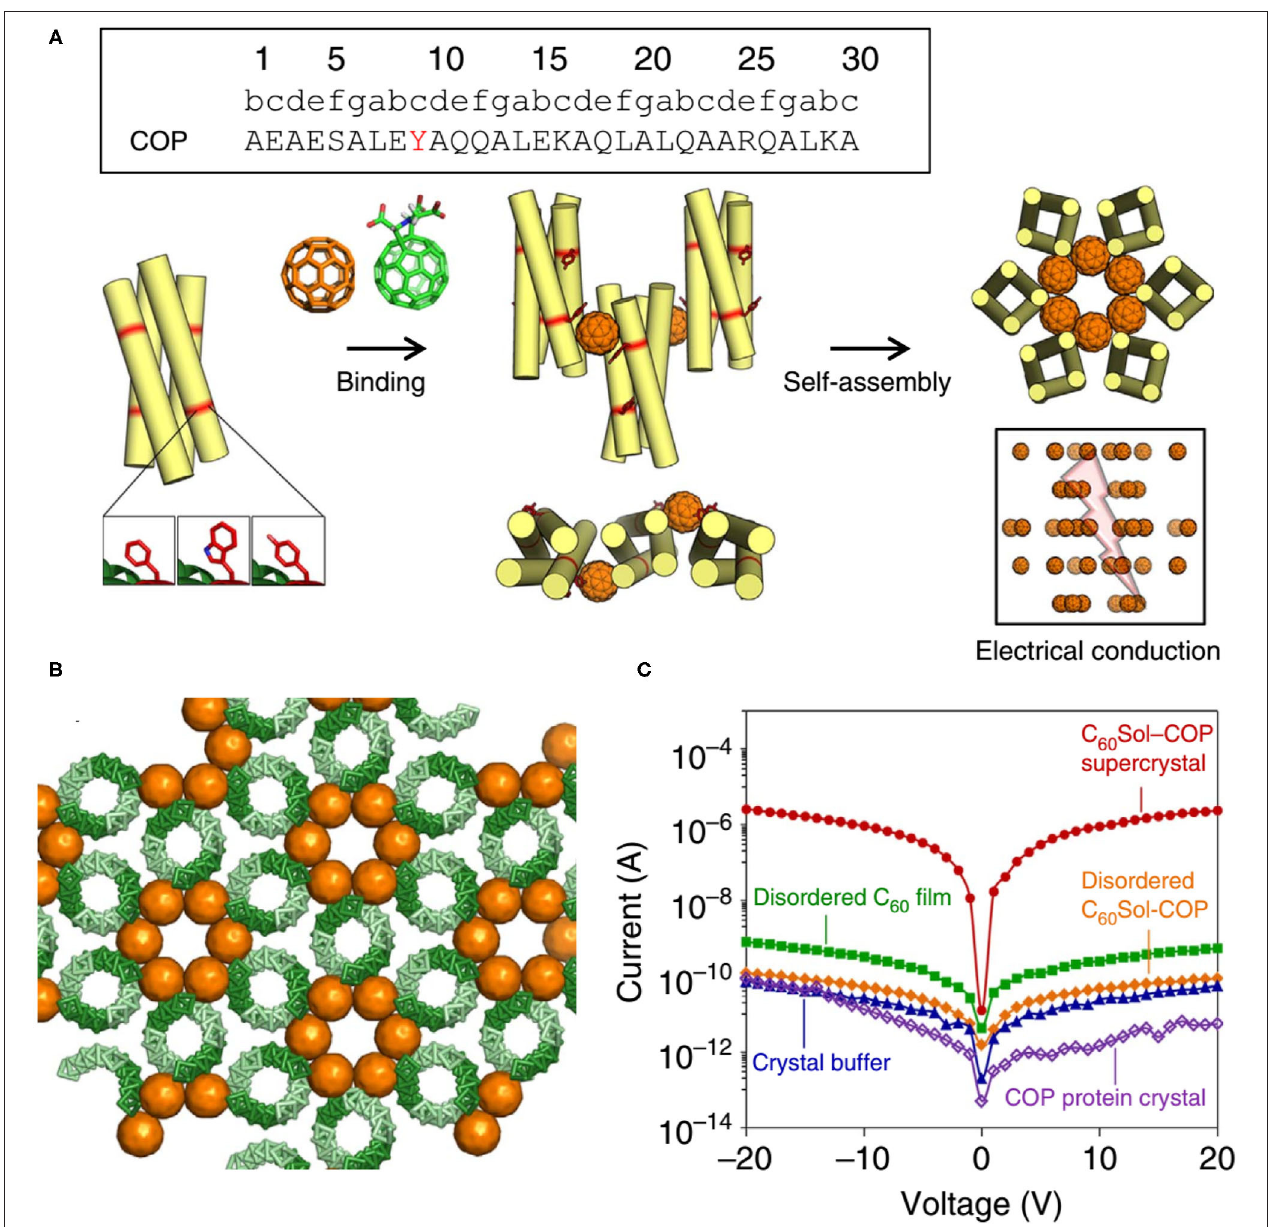
FIGURE 10 | Protein assemblies for bio-electronic applications. (A) COP interacts with C 60 by means of a surface-binding site that includes Tyr residues, and self-assembles into a co-crystalline array with fullerene. (B) The C 60 Sol-COP crystal lattice. (C) Semi-logarithmic current-voltage characteristic of C 60 Sol-COP super crystal (red dots) and disordered C 60 Sol-COP (orange diamonds) and other controls. Reprinted with permission from Kim et al. (2016). Copyright 2015 Macmillan Publishers Limited.